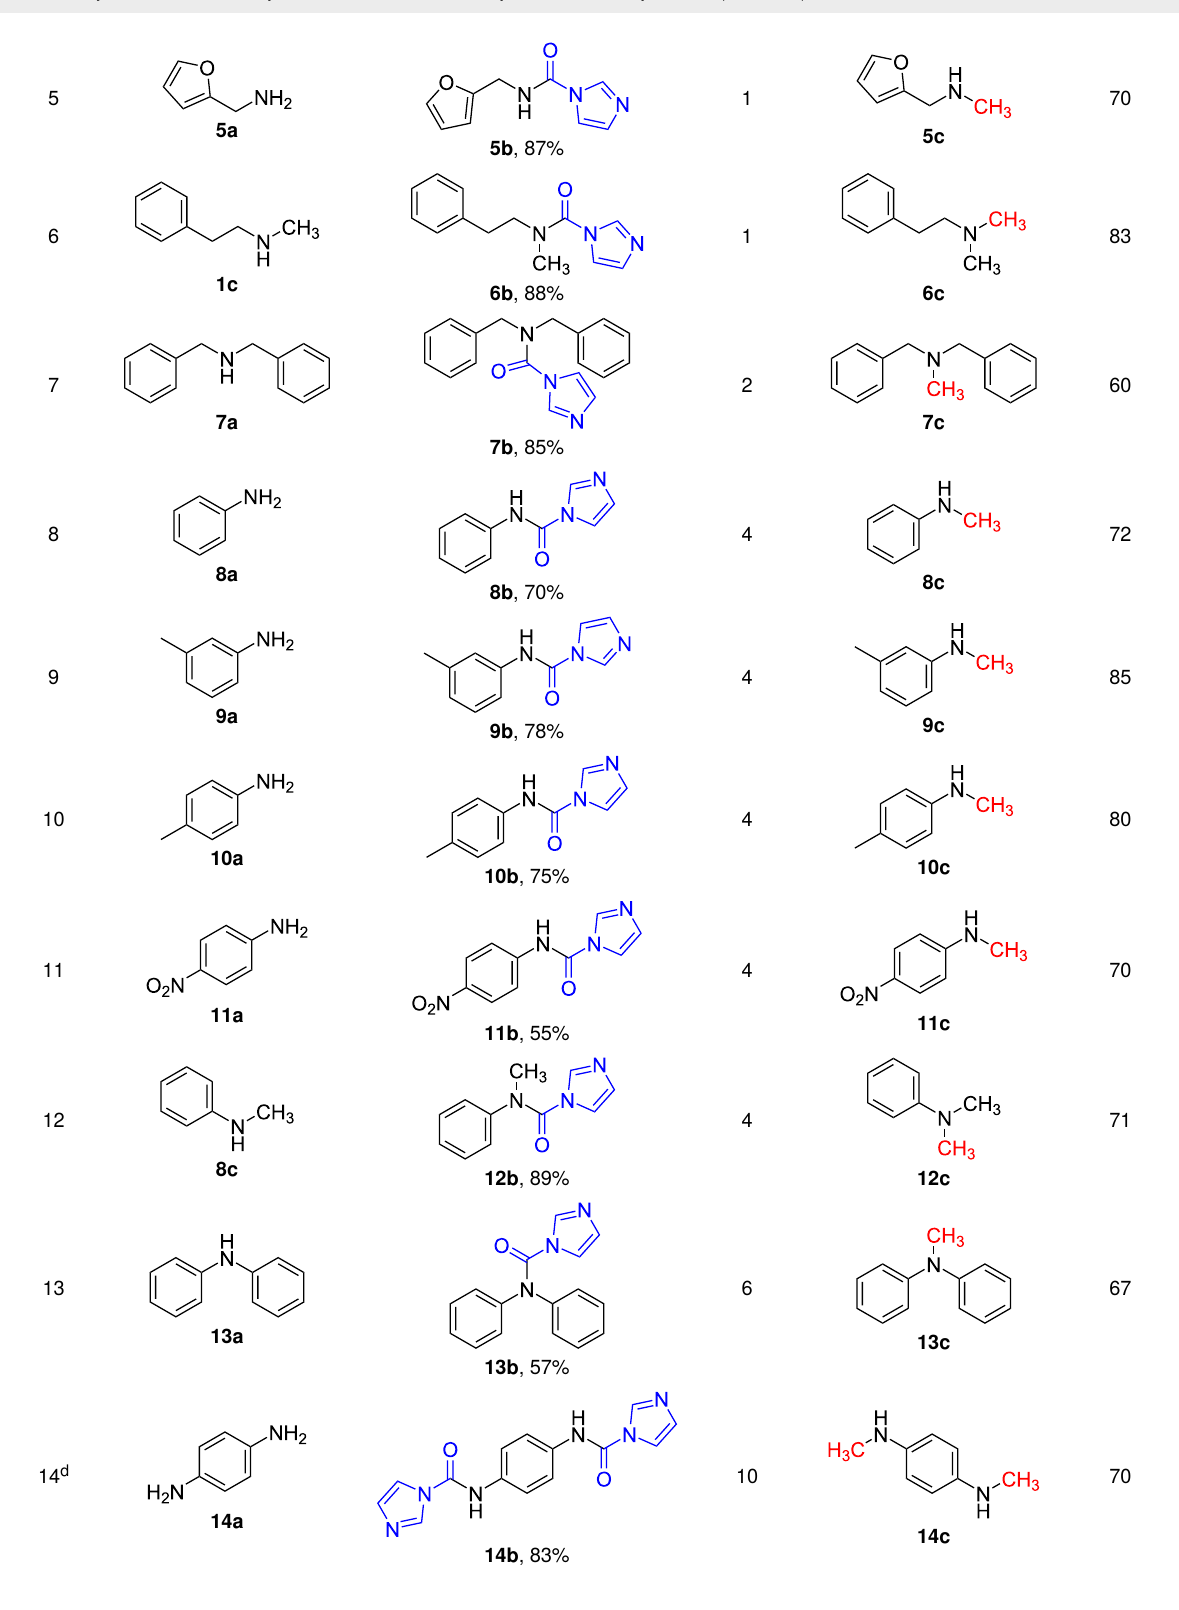
Table 2: Synthesis of monomethylamines from amines, carboxylic acids and isocyanates. a